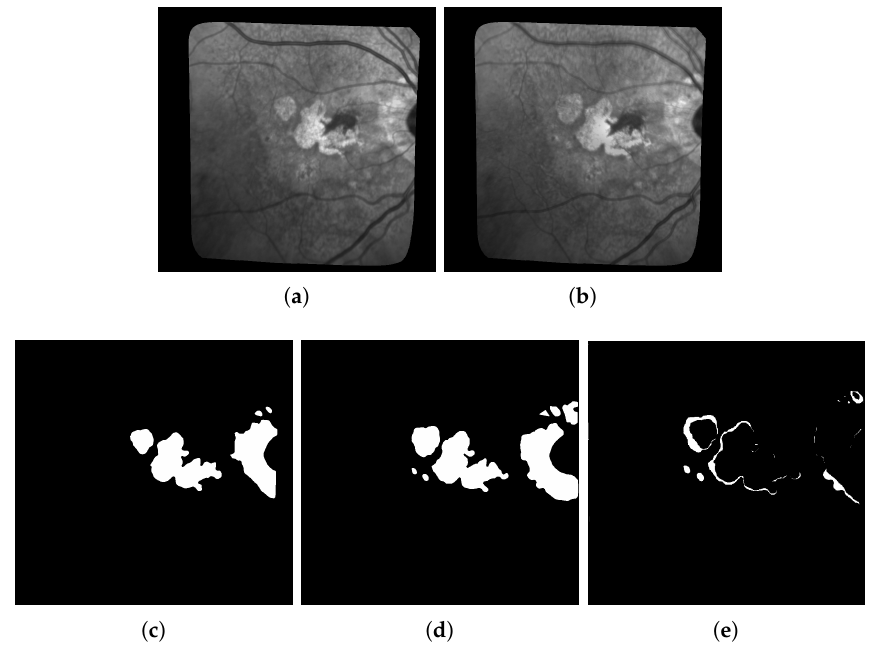
Figure 12. Example of ground-truth build for patient 010 based on two consecutive masks of segmented lesions at time t and t + 1: All changes inside the lesions, textural or otherwise, are ignored. ( a ) Image t ; ( b ) Image t + 1; ( c ) segmentation mask t ; ( d ) segmentation mask t + 1; ( e ) Ground truth built from Mask t and t +